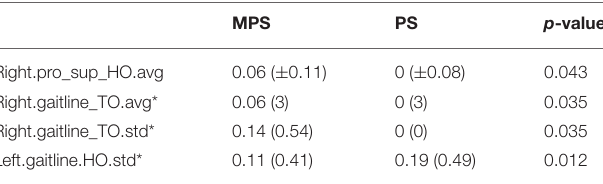
TABLE 3 | Gait analysis variables analyzed with PODOSmart ® which presented statistically significant difference ( p < 0.05) among the MPS and PS. MPS PS p -value